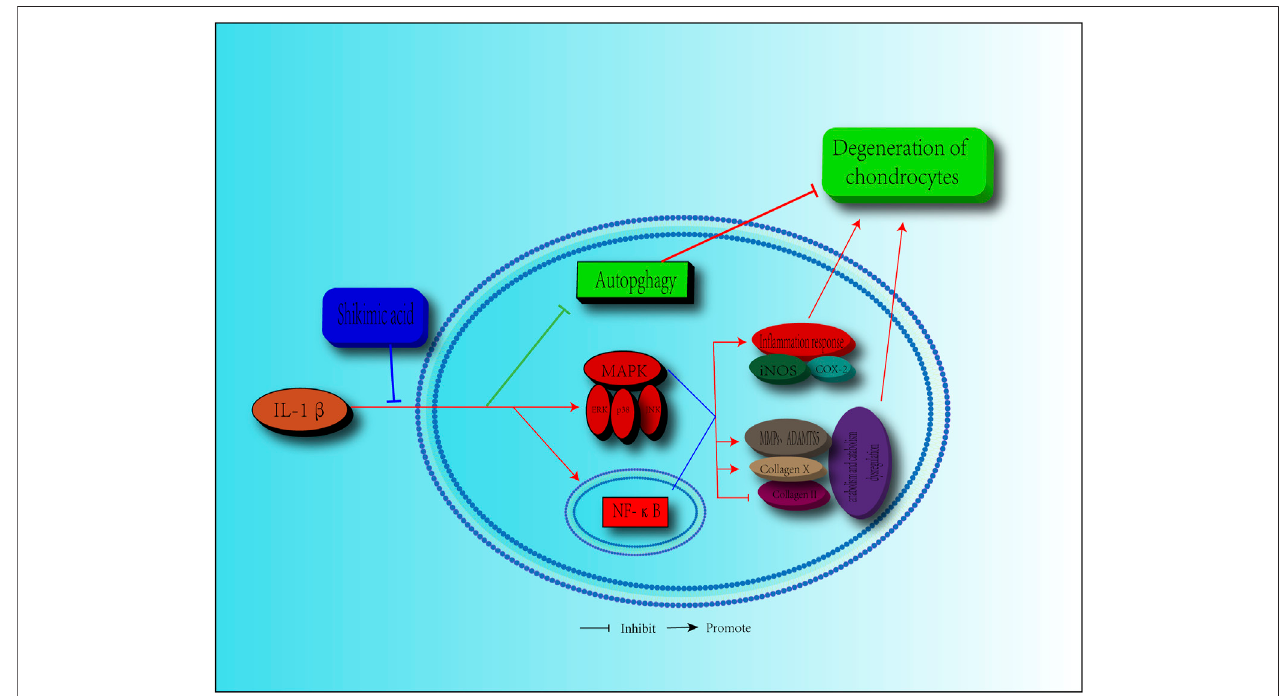
FIGURE 9 | Schematic diagram of the effect of SA on cartilage degeneration. IL-1 β induces the expression pro-in fl ammatory factors, including iNOS, COX2, MMPs, and ADAMTS5. IL-1 β stimulates the increasing ofcollagen X,degradation ofcollagenII and impairmentof autophagy. Furthermore, IL-1 β functions byactivating the MAPK and NF- κ B signaling pathways, as shown by, the increase in the level of p -ERK, p-p38, p -JNK, p -IKK α / β , p-p65, and the translocation of p65. However, SA can reverse these effects.